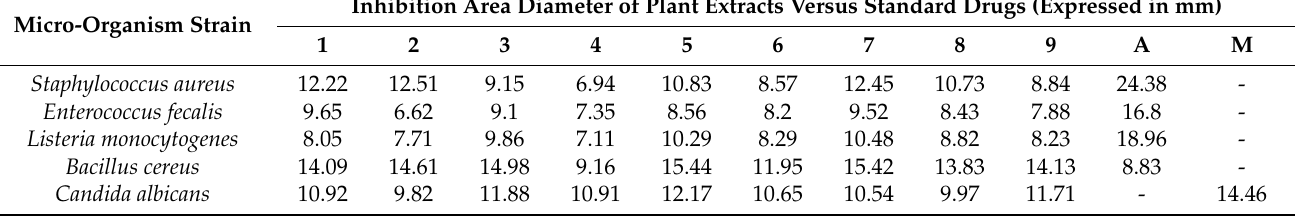
Table 7. The results of the in vitro qualitative screening—the disk diffusion test. Micro-Organism